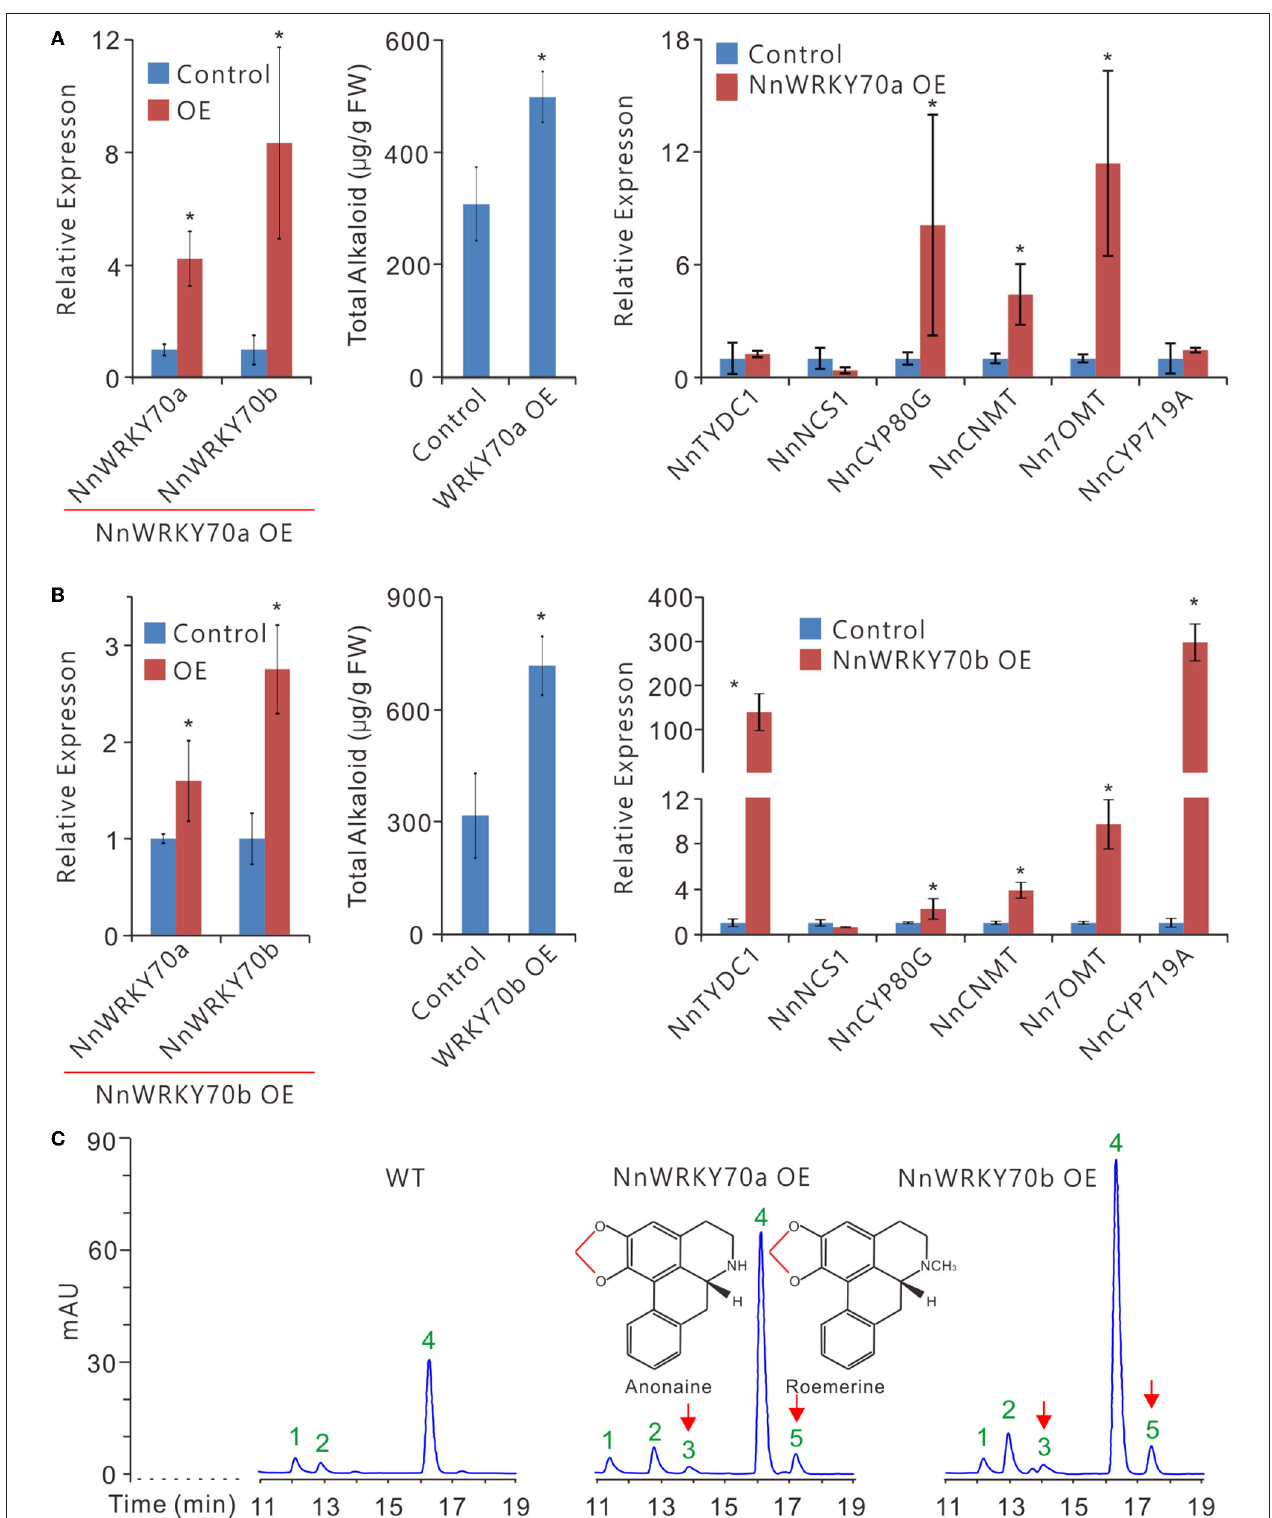
FIGURE 5 | Transient overexpression of NnWRKY70a and NnWRKY70b significantly enhances BIA accumulation in lotus petals. (A,B) Effects of NnWRKY70 overexpression on BIA biosynthesis in lotus. Left panel, expression of NnWRKY70a and NnWRKY70b ; Middle panel, BIA concentration; Right panel, expression of BIA pathway genes in lotus petals overexpressing NnWRKY70 s. (C) HPLC scanning of BIA constituents and their abundance in lotus petals. Data are means ± SE ( n = 3). Asterisks (*) represents significant differences at P < 0.05. Peak signals 1-5 represent N -nornuciferine, O -nornuciferine, anonaine, nuciferine, and roemerine alkaloids, respectively. Chemical bonds marked in red are methylenedioxy bridges formed by the catalytic activity of NnCYP719A. Frontiers in Plant Science |